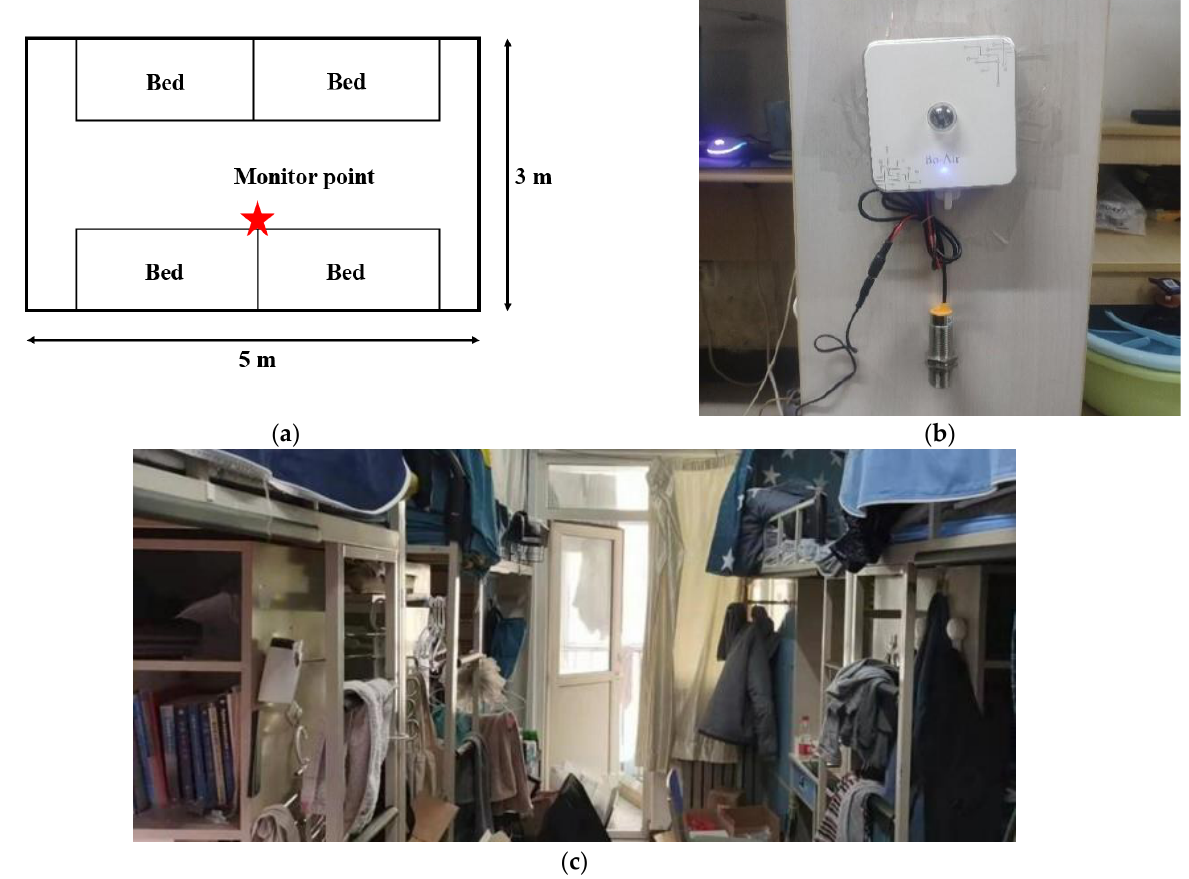
Figure 1. ( a ) Four-bed dormitory room plan; ( b ) Installation location of the monitoring kit; ( c ) Typical scene in a dormitory.